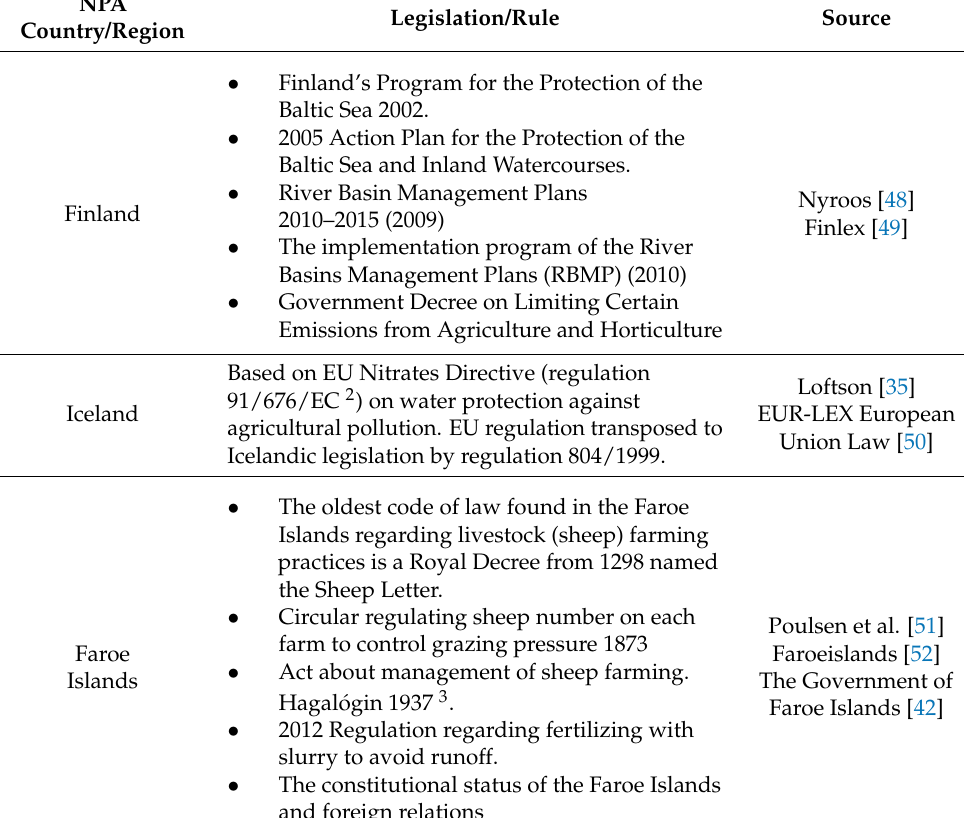
Table 3. NPA country/region water legislation for the prevention of environmental pollution from agricultural